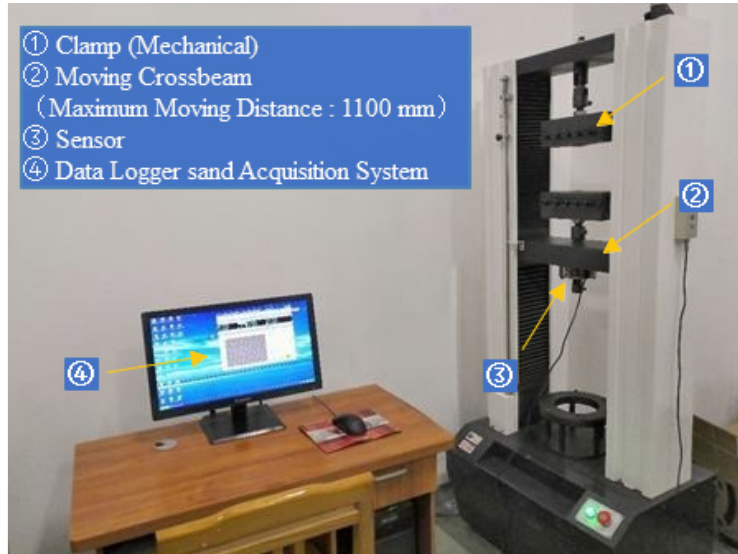
Figure 1. The geosynthetics electronic strength tester.